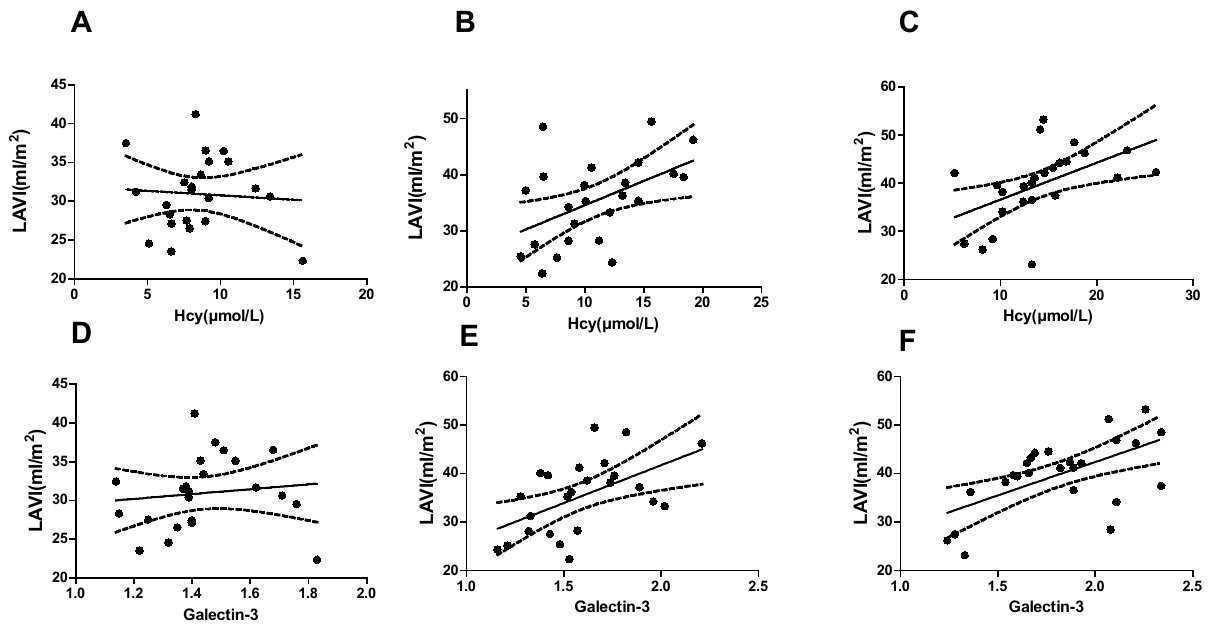
Figure 3: The correlation between serum Hcy, Galectin-3 concentration and LAVI in different groups(A: Correlation between LAVI and Hcy in control group; B: Correlation between LAVI and Hcy in PaAF group; C: Correlation between LAVI and Hcy in PeAF group; D: Correlation between LAVI and Galectin-3 in control group; E:Correlation between LAVI and Galectin-3 in PaAF group; Correlation between LAVI and Galectin-3 in PeAF